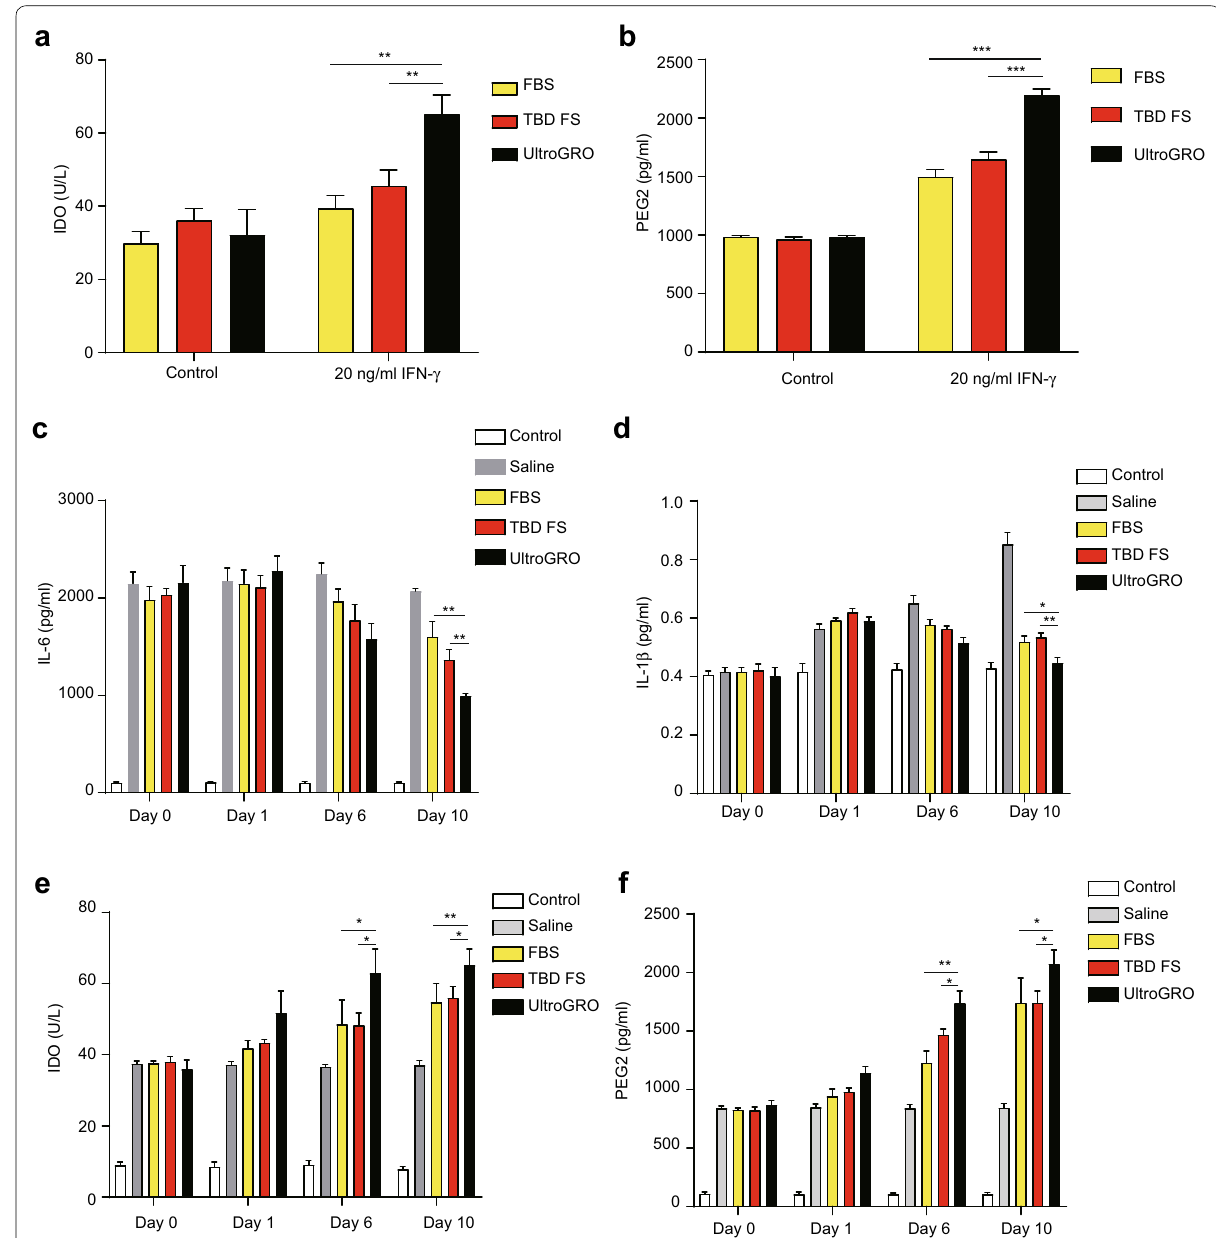
Fig. 4 The measurement of UC-MSCs secreted cytokines in vitro and in vivo. a , b The anti-inflammatory cytokines IDO and PEG2 secreted by UC-MSCs were measured by ELISA after being treated with 200 ng/ml IFN-γ. c , d The IL-6 and IL-1β were measured by ELISA in a TNBS-induced colitis mouse model. e , f The IDO and PEG2 were measured by ELISA in aTNBS-induced colitis mouse model. **p < 0.01, * p < 0.05, Student’s t -test. For all experiments, n 3 healthy donors/group, and data shown are mean = ±